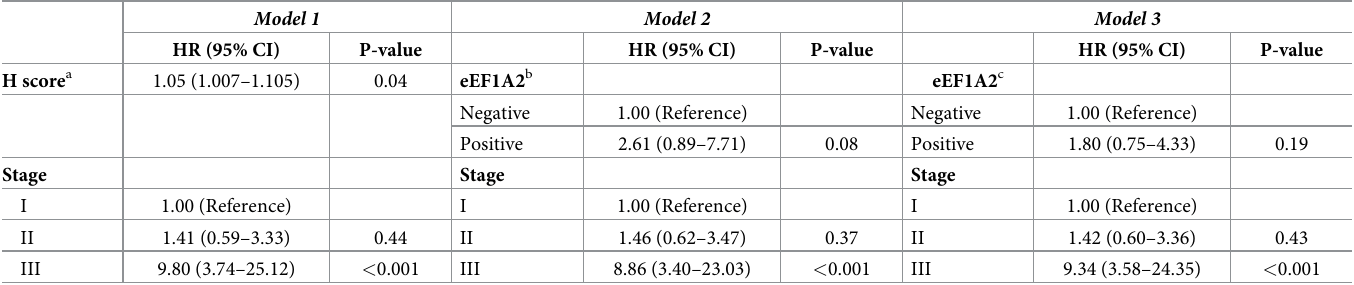
Table 5. Results from multivariate Cox models for DFS.